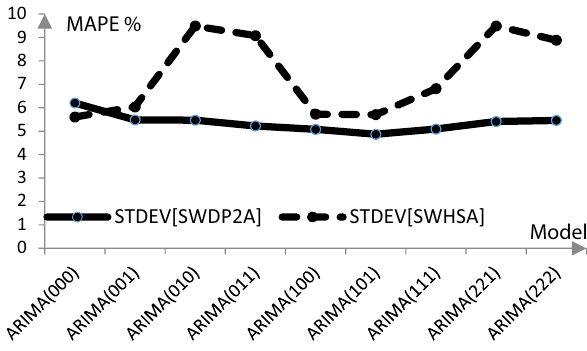
Fig. 7 Algorithm stability comparison in terms of standard deviation